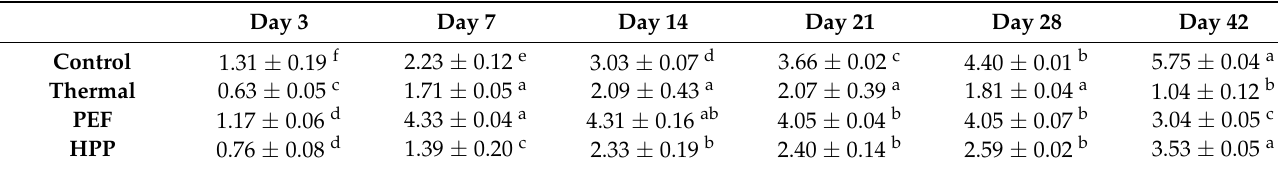
Table 4. Color difference ( ∆ E) compared to the respective sample directly after processing along with storage for the strawberry–kale mix. Different letters indicate significant differences during storage per row ( p < 0.05) (n =